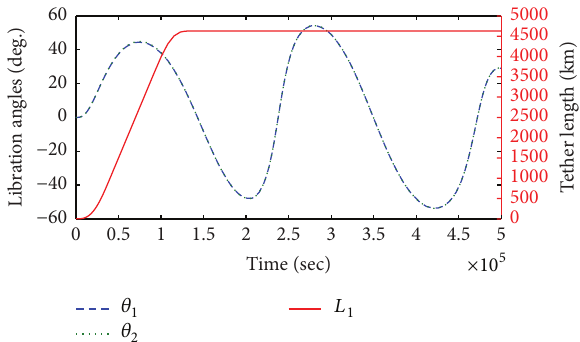
Figure 11: Libration angles and tether length 𝐿 1 by the formulations based on point 𝐶 with a prescribed function 𝐿 1 (𝑡)